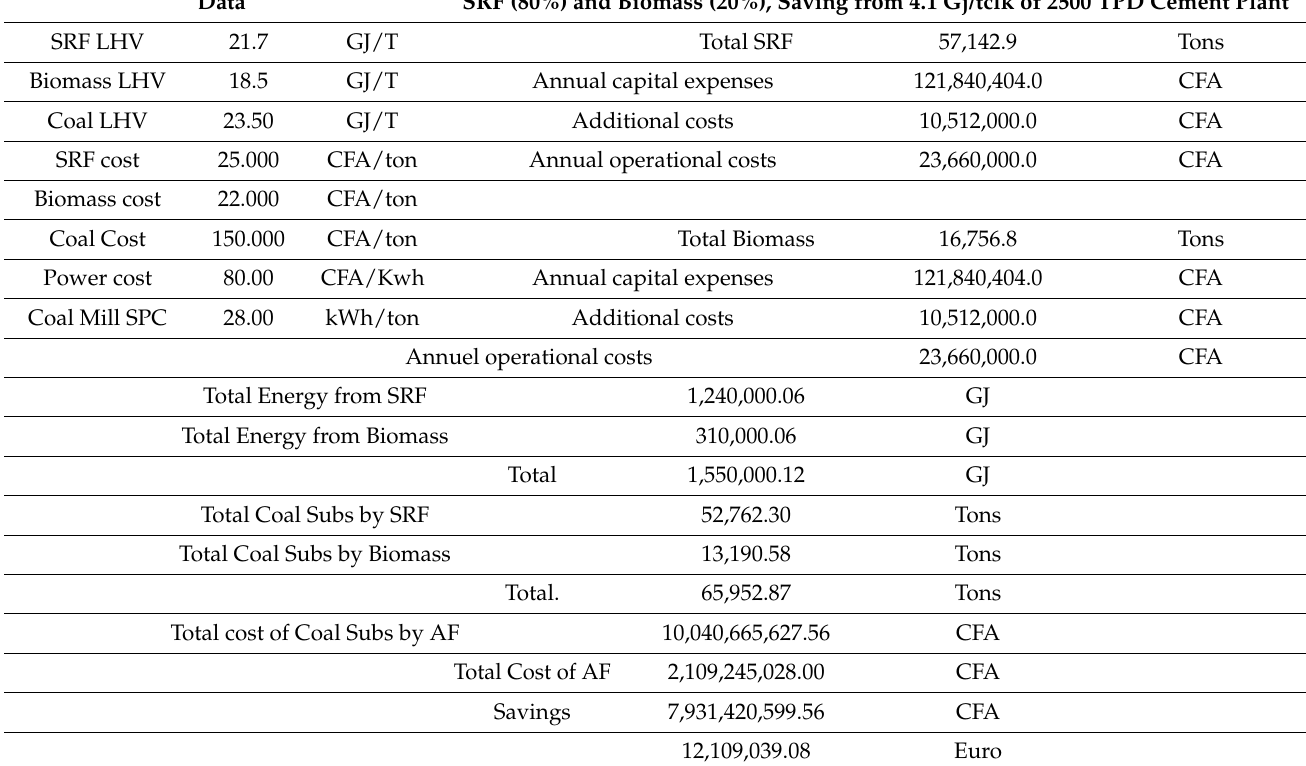
Table 9. Cost saving for 50% substitution for suspension preheater